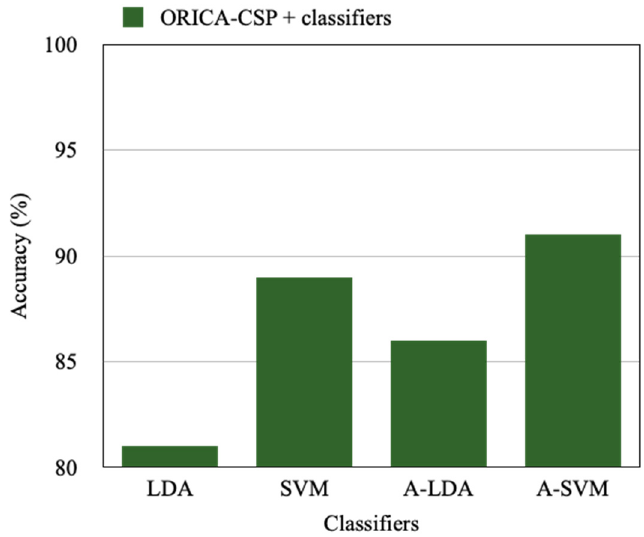
Figure 13. Comparative results of the proposed feature extraction method with different classifiers.